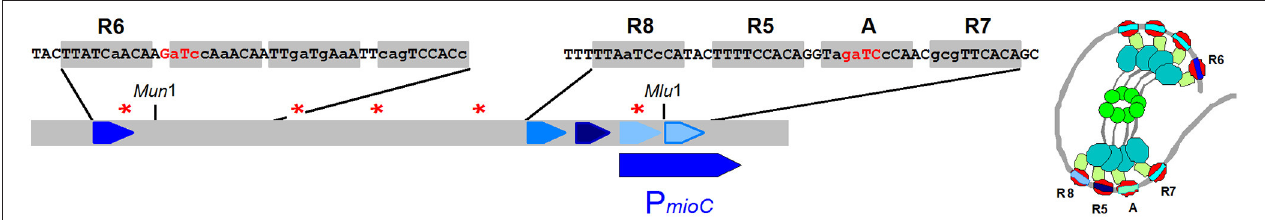
FIGURE 7 | The five experimentally verified DnaA boxes in the mioC region are named above the sequence boxes (Hansen et al., 2007) but also potential box sequences to the right of the R6 box are indicated. GATC sites are indicated with red stars (or red letters). To the right is a speculative view of DnaA protein bound to the DnaA-boxes in the mioC region (see Figure 5 for domain